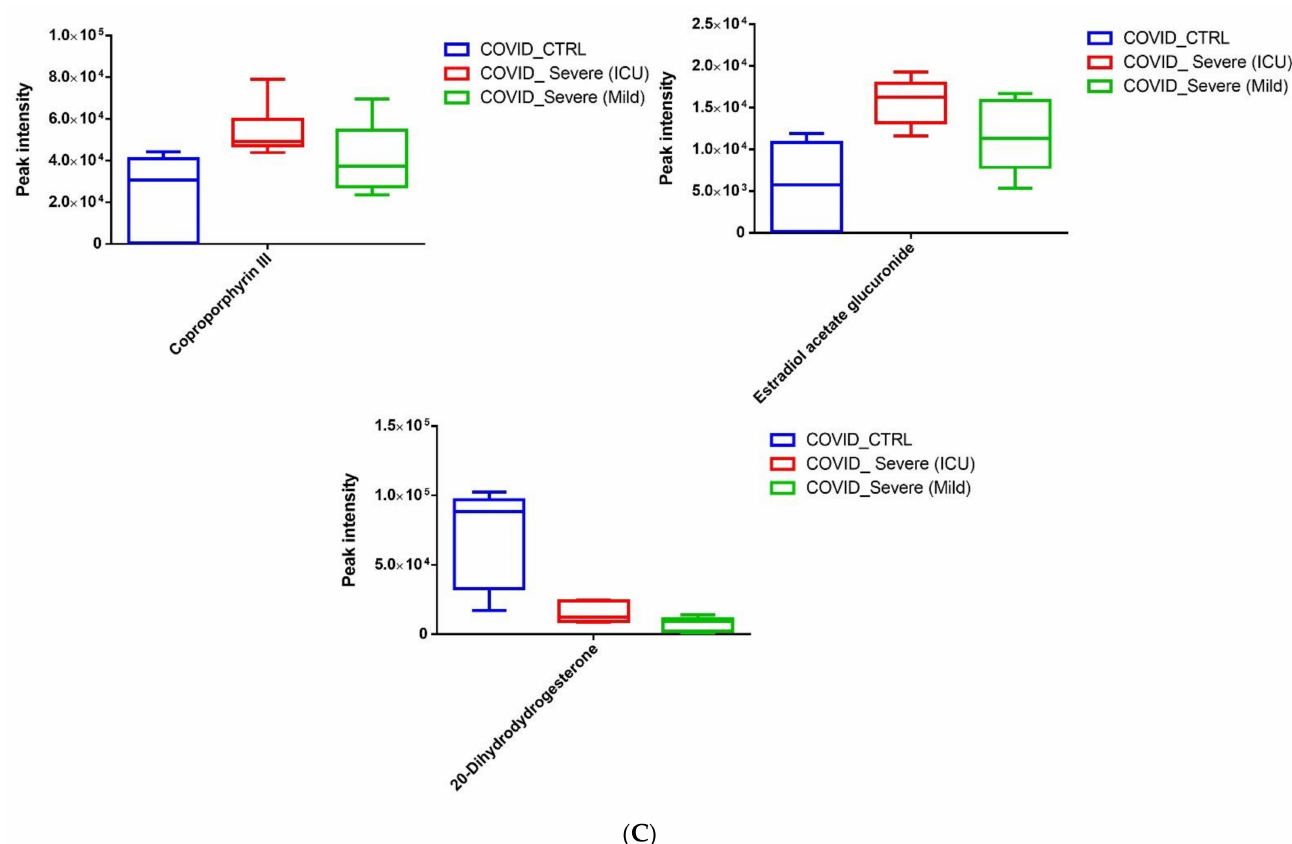
Figure 5. ( A – C ) Quantitative levels of statistically significant metabolites ( p < 0.01) found to be upregulated in COVID-19 EVs when compared to healthy samples. Data are presented as box plot, median, and interquartile range (n =